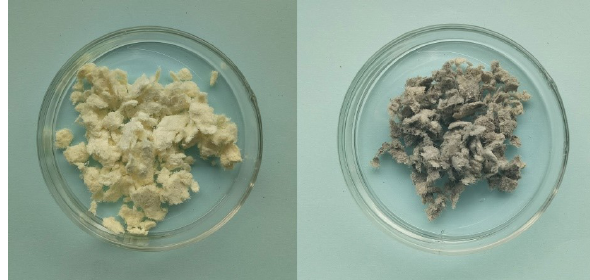
Figure 5: Photos of AFs before and after being treated